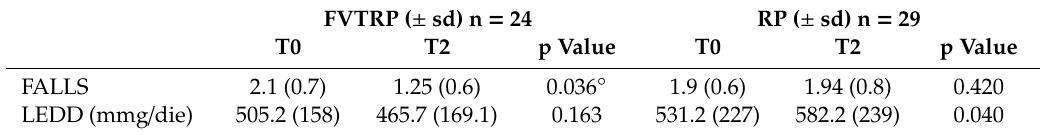
Table 3. Di ff erences between FVTRP and RP at follow-up; we used Monte Carlo (MC) method for the mean falls per month (FALLS) and repeated measures ANOVA for the levodopa equivalent daily dosage (LEDD); ◦ upper limit of the confidence interval of the Monte Carlo method lower than